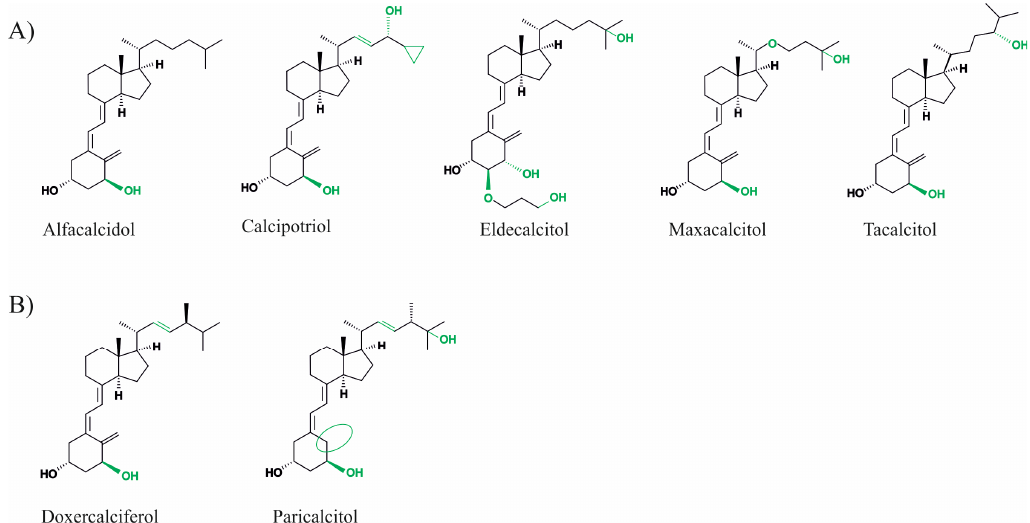
Figure 1. Chemical structure of vitamin D 3 derivatives ( A ) and vitamin D 2 analogues ( B ). Structural changes between the analogues are highlighted in green or with green circles.